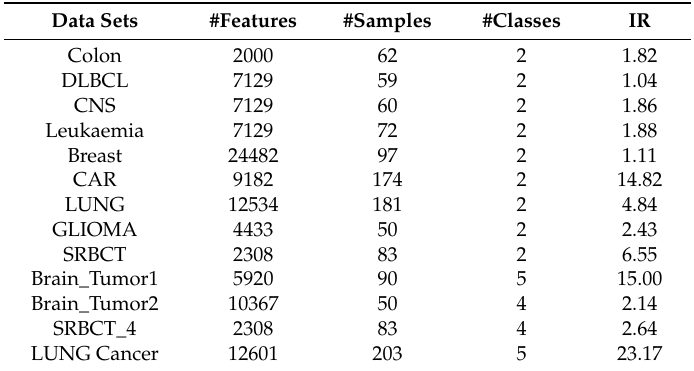
Table 2. Data sets and their characteristics used in this paper for evaluation.